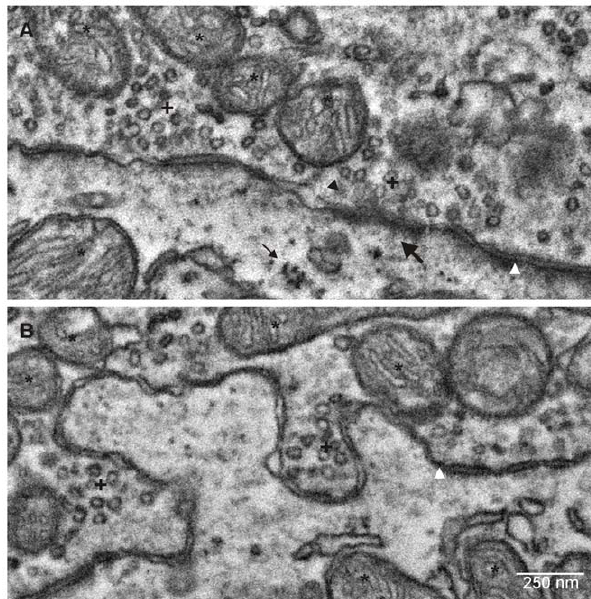
Figure 4. S 3 EM enables the acquisition of high resolution and high quality electron micrographs from large tissue volumes. A: Consecutive sections of a segment of the calyx of Held synapse (coH) and the corresponding MNTB principle cell (postsyn.) at 10,000fold magnification (3.7 nm/pixel). Cellular protrusions can be followed through the tissue (asterisks), and cellular compartments and fine structure can be recognized. Boxed areas are shown in detail at smaller scale in B–E . B: Detailed image of a synaptic release site, characterized by the cluster of synaptic vesicles and the electron-dense postsynaptic density. Scale as in D. C: Detailed image of a mitochondrion. The cristae are clearly visible. Scale as in D. D: Detailed image of a synaptic vesicle cluster. E: Detailed image of a part of the synaptic cleft.